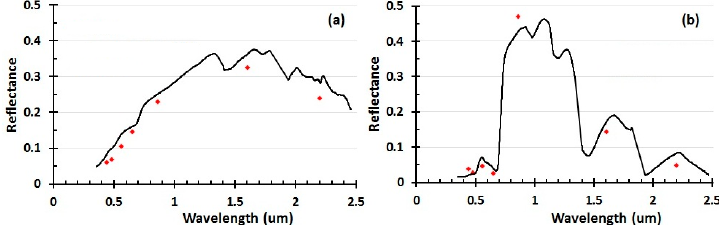
Figure 5. Examples to show the mean reflectance of atmospherically corrected Landsat-8 OLI (red points) in two ROIs and their matched spectrum in the USGS spectral library (curves): ( a ) desert; and ( b ) vegetation.